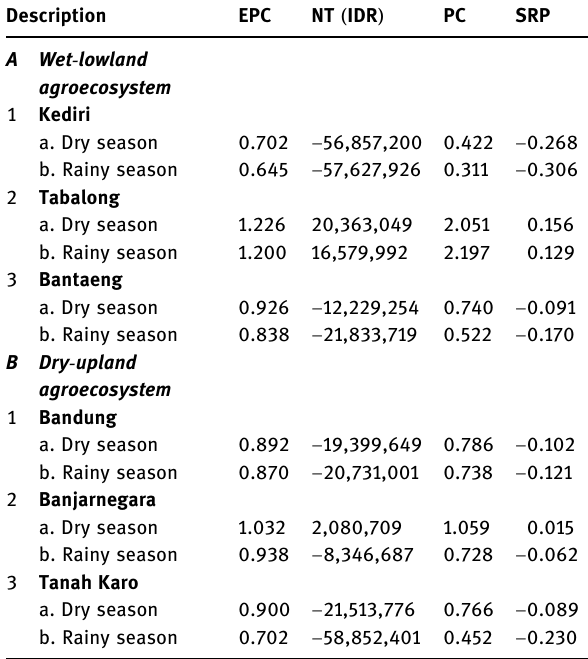
Table 6: NT, PC, EPC, and SRP values of chili farming in